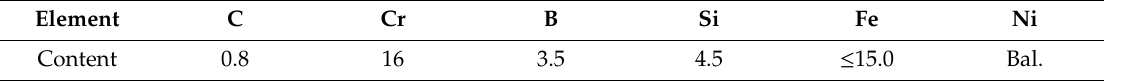
Table 2. Chemical composition of the Ni60 alloy powder (wt.%).